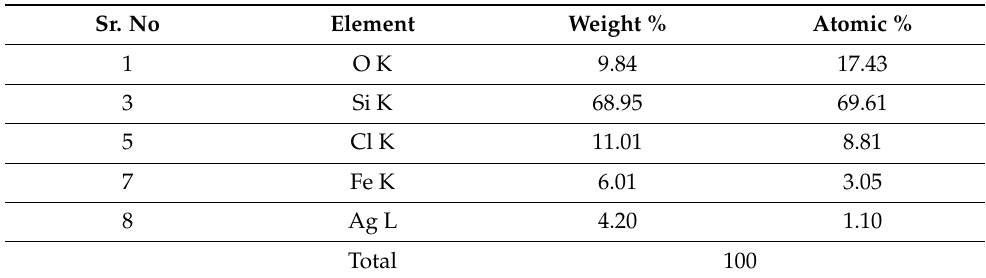
Table 7. Summary of the results for the EDS analysis of the aggregate of silver